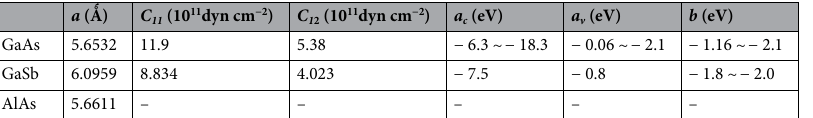
Table 3. The material parameters of GaAs, GaSb and AlAs.